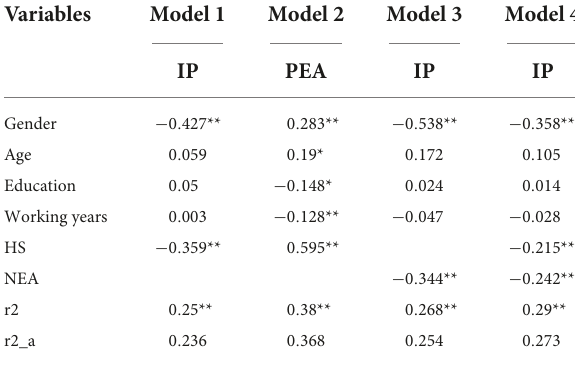
TABLE 3 Results of mediation of positive emotional atmosphere in the relationship between challenge stressor and innovation performance.